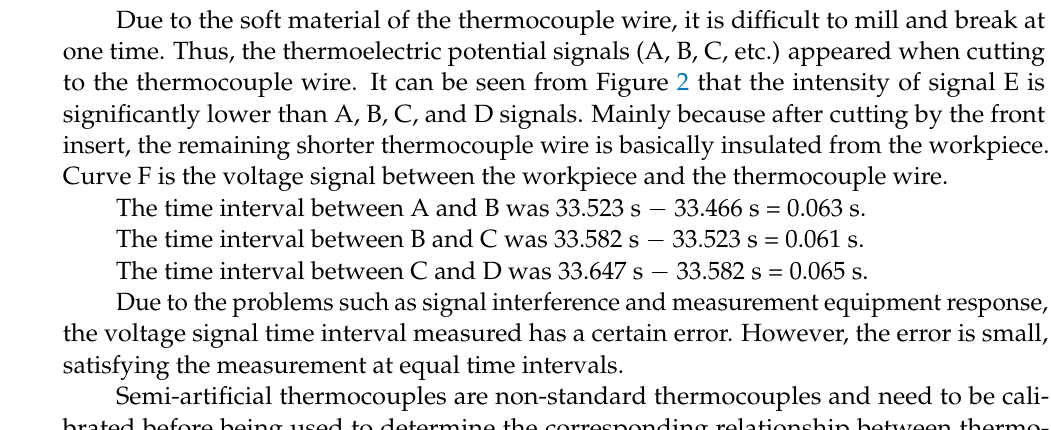
Figure 2. Thermoelectric potential signal diagram of the milling process measured by the e x − periment.